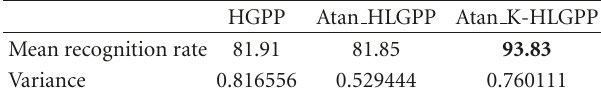
Table 5: Experiment result on FERET200 (rank-1 recognition